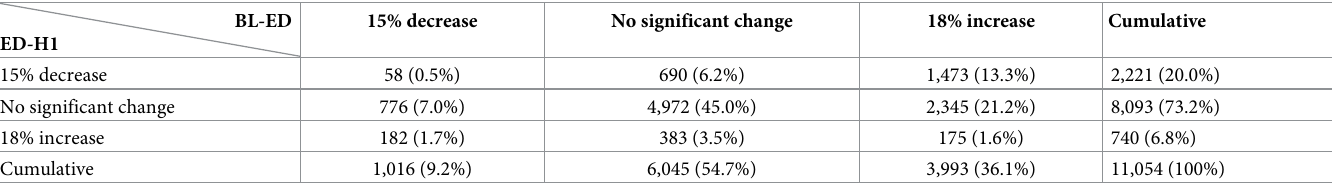
Table 2. Relative changes of serum creatinine (SCr) measurement between baseline (BL), emergency department (ED) and the SCr measured during hospitalization